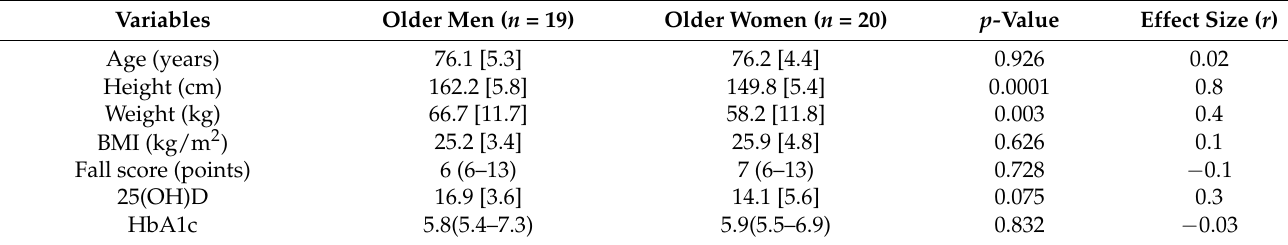
Table 1. Characteristics of the